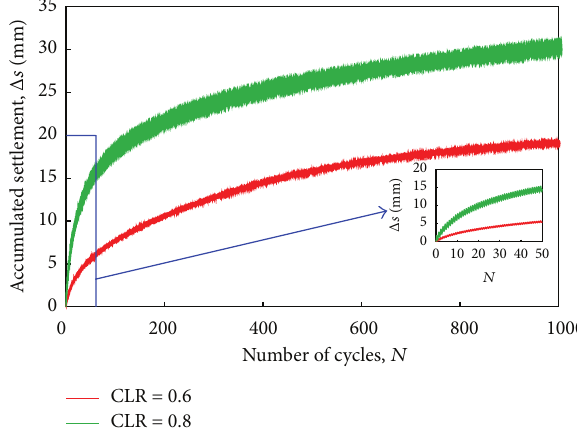
Figure 7: The cyclic loading regime. Table 2: Cyclic loading test programme.